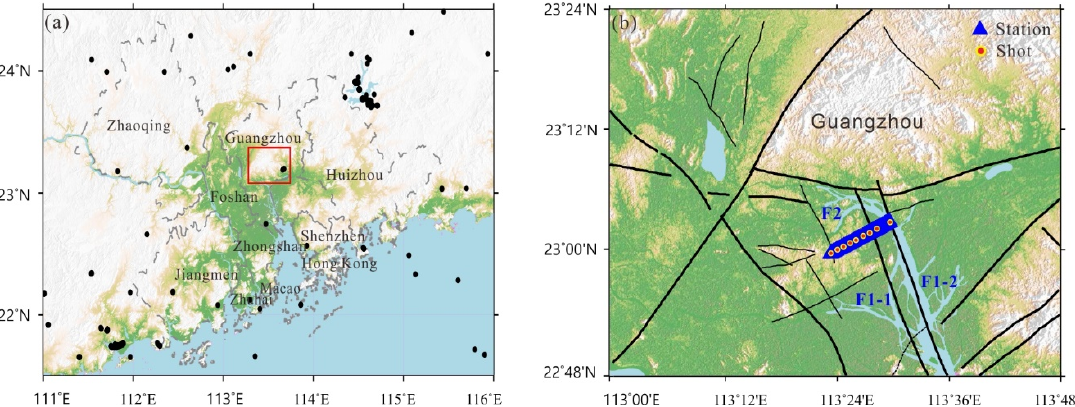
Figure 1. ( a ) A map showing the study area. Black dots indicate earthquakes with magnitudes ≥ 2 between 2008 and 2021, as obtained from the China Earthquake Networks Center. ( b ) Geological map showing the survey profile. While the blue triangle represents the instrument’s station, the red circle represents the source position. PREF (F1) comprised two branches: Hualong fault–HLF (F1-1) as the east branch and Wenchong fault–WCF(F1-2) as the west branch. However, F2 indicates BNF.